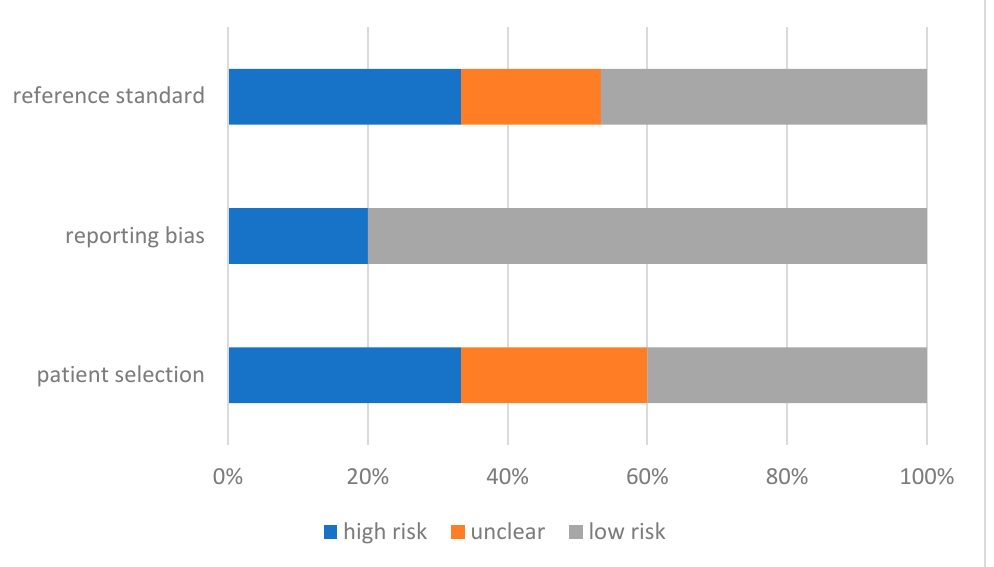
Figure 3. QUADAS-2 score for applicability of bias across all studies for the included studies in the systematic review of cut-off values for troponin in patients with chronic kidney disease.